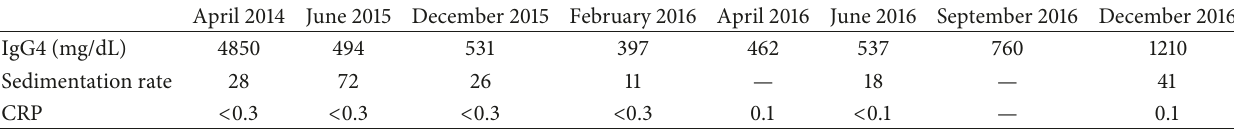
Table 2: Laboratory results before and after prednisone (prednisone was started on June 2015 and discontinued on November